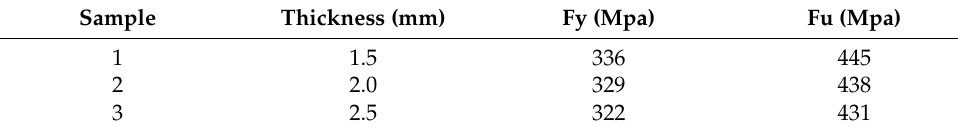
Table 2. Steel properties.